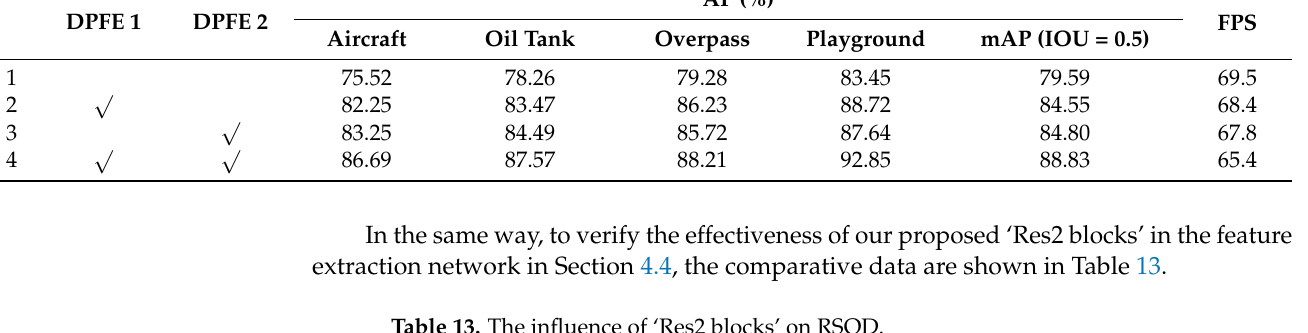
Table 13. The influence of ‘Res2 blocks’ on RSOD.